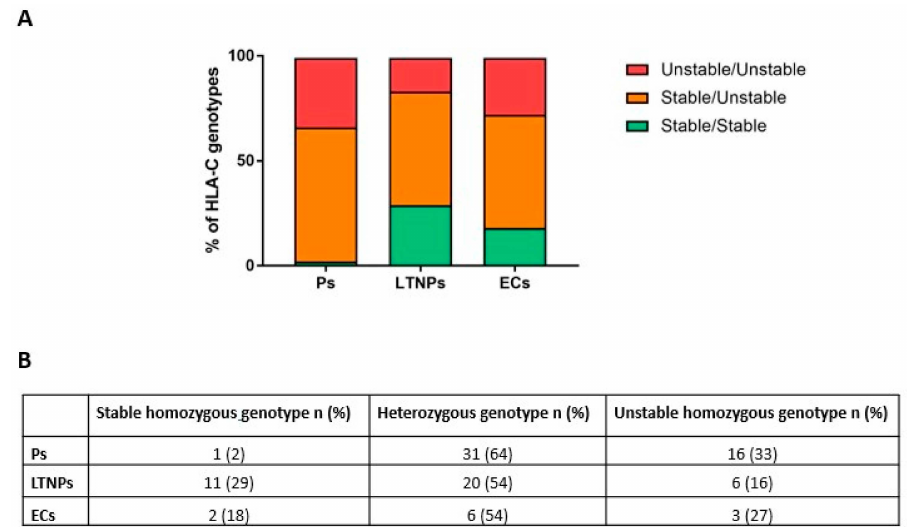
Figure 2. Graphical percentage distribution of HLA-C genotypes for each category of HIV-1-positive patients ( A ). Number and percentage of subjects for each category ( B ). p -value computed through chi-square test.